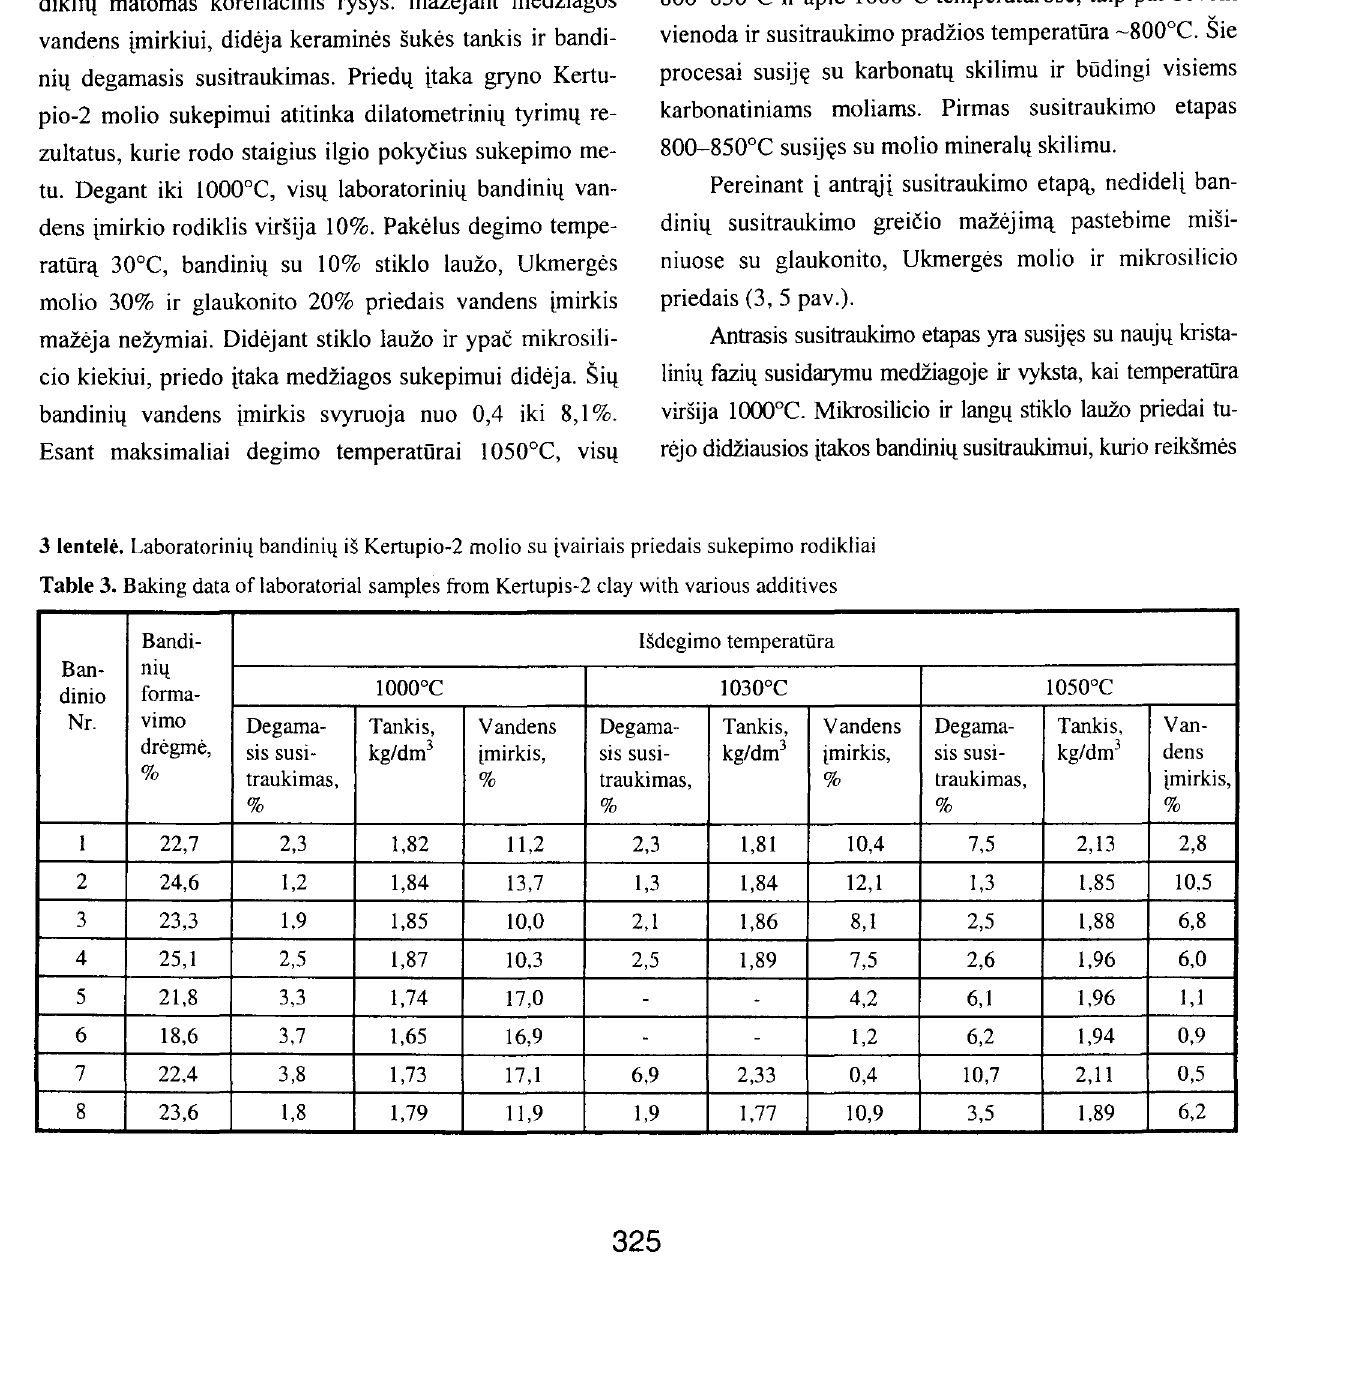
Table 3. Baking data of laboratorial samples from Kertupis-2 clay with various additives